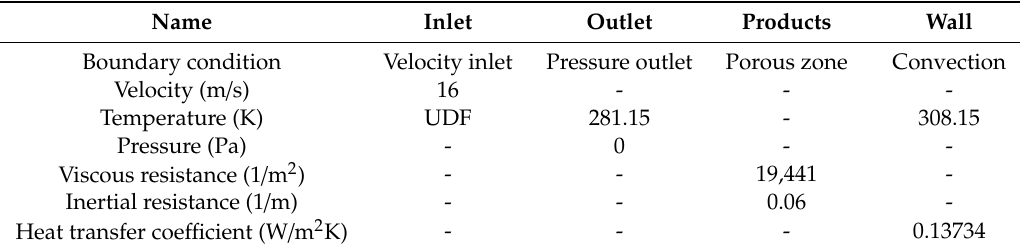
Table 2. Details of boundary